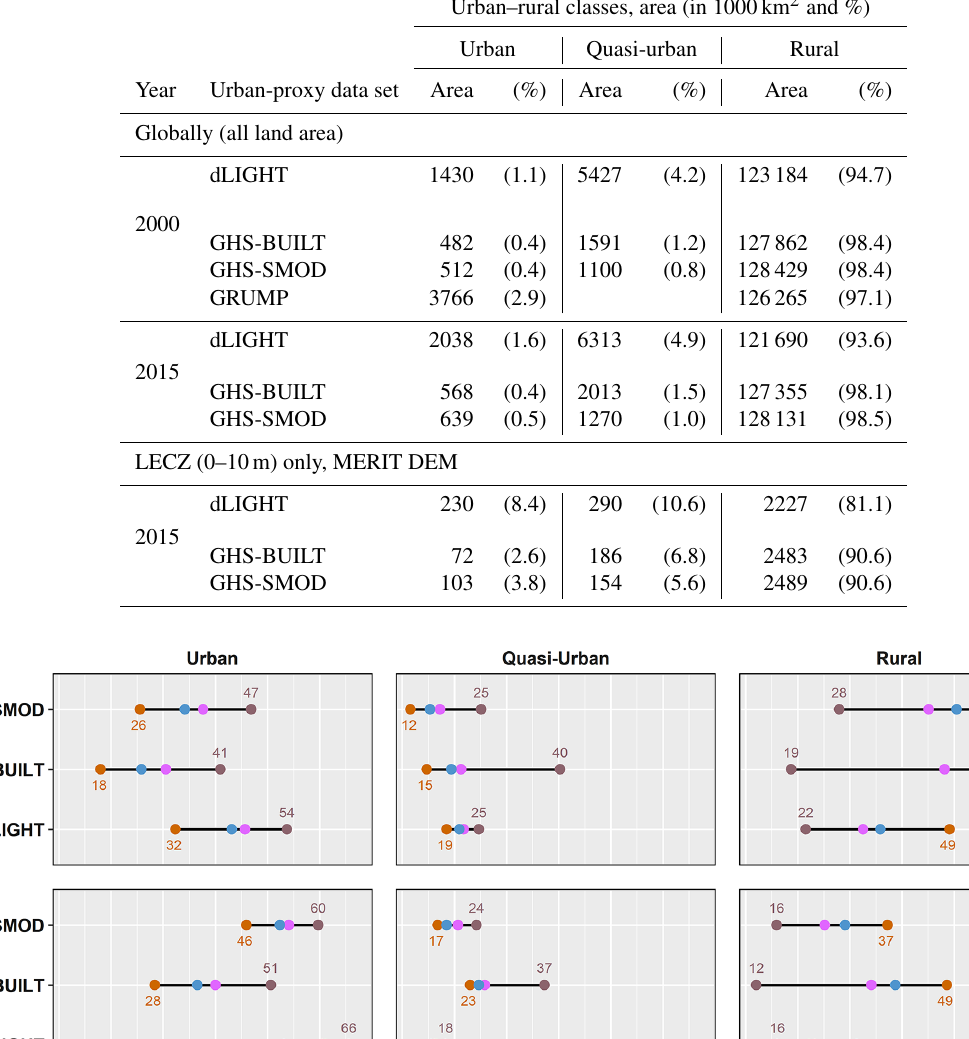
Table 6. Land area of urban, quasi-urban and rural by urban-proxy data sets.